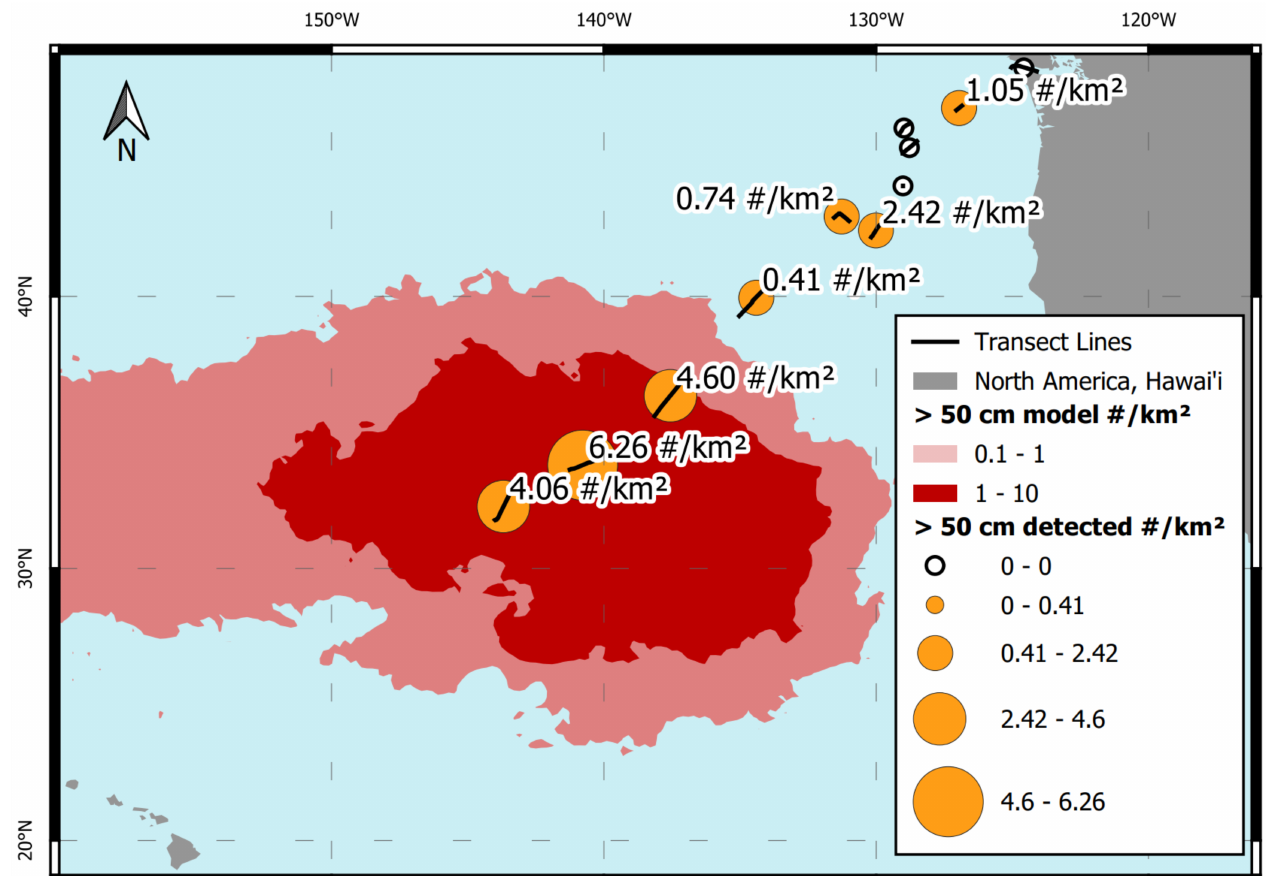
Figure 10. Update of the map in Figure 2 with numerical concentrations of macroplastic (>50 cm) indicated by circle size and labels from the Yolov5 results. Black lines indicate photo footprints during mission NPM3. The gaps are mainly caused by transit during nighttime, at which no photos were recorded. The light and dark red shaded polygons indicate the estimated outer and inner areas of the Great Pacific Garbage Patch (GPGP), respectively